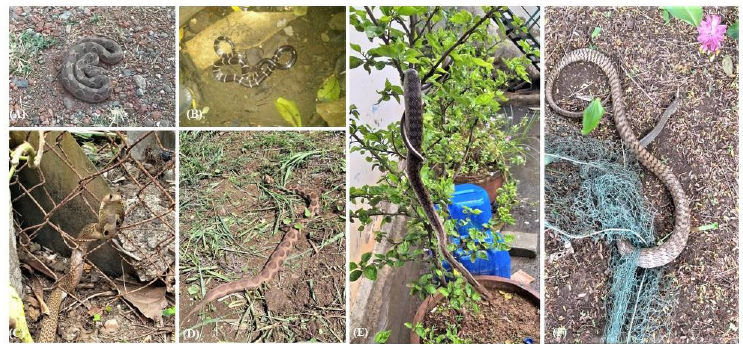
Fig 2. Commonly found venomous and non-venomous snakes in Dahanu block, Maharashtra, India. Venomous snakes: (A) Saw scaled viper (B) Common krait (C) Cobra (D) Russell viper; Non-venomous snakes (E)Trinket snake (F) Rat snake. Photo credit: Mr. Sagar Vijay Patel, Forest Department/Biodiversity Department, Dahanu, Maharashtra,